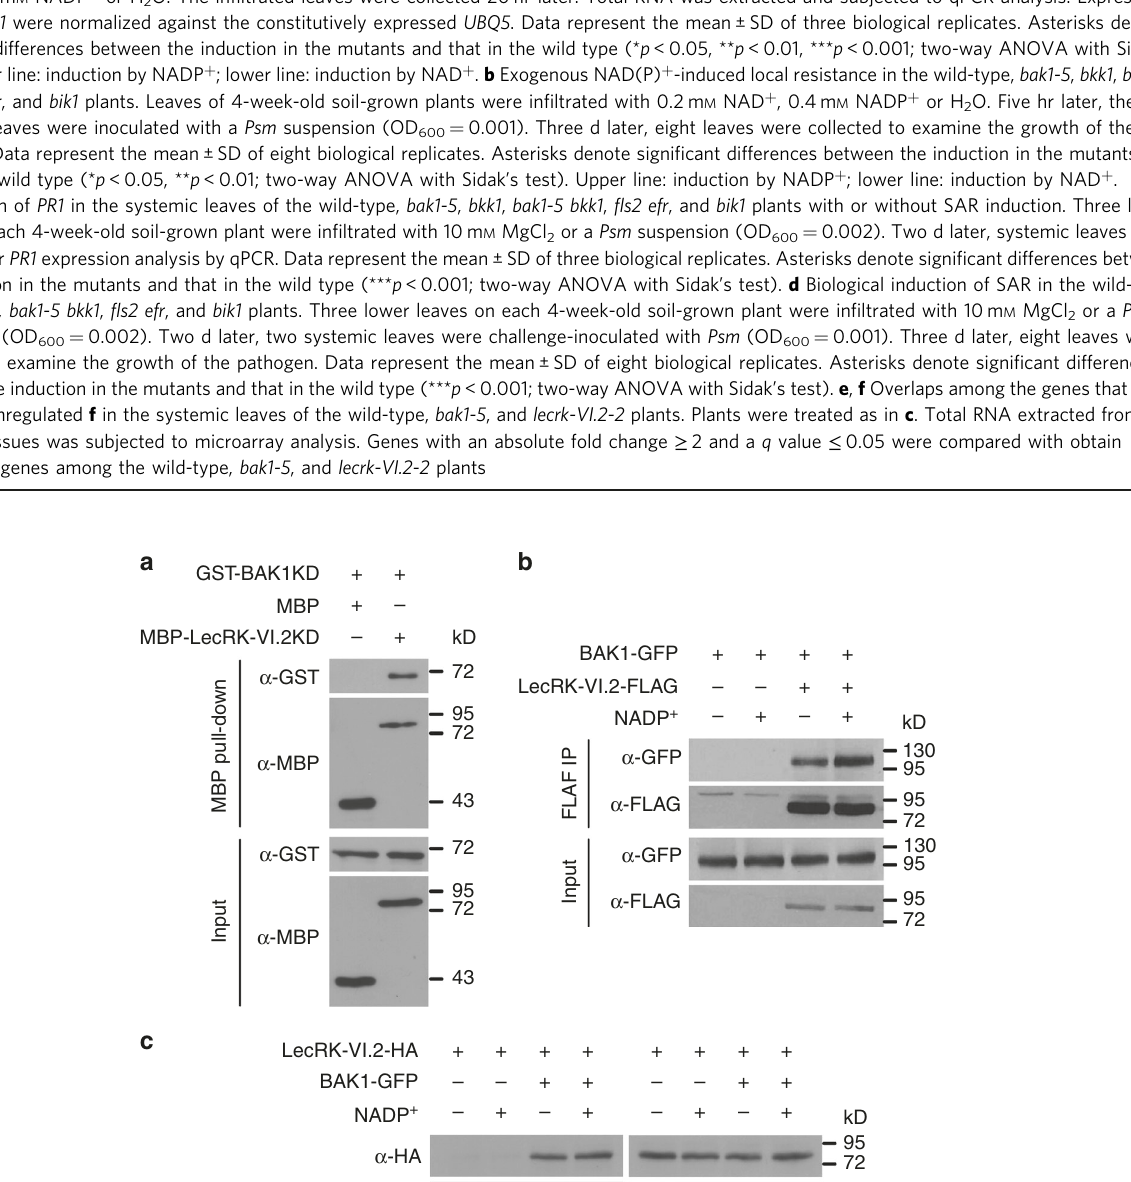
Fig. 5 Exogenous NAD(P) + -induced local immune responses and biological induction of SAR in several PTI mutants. a Exogenous NAD(P) + -induced local PR1